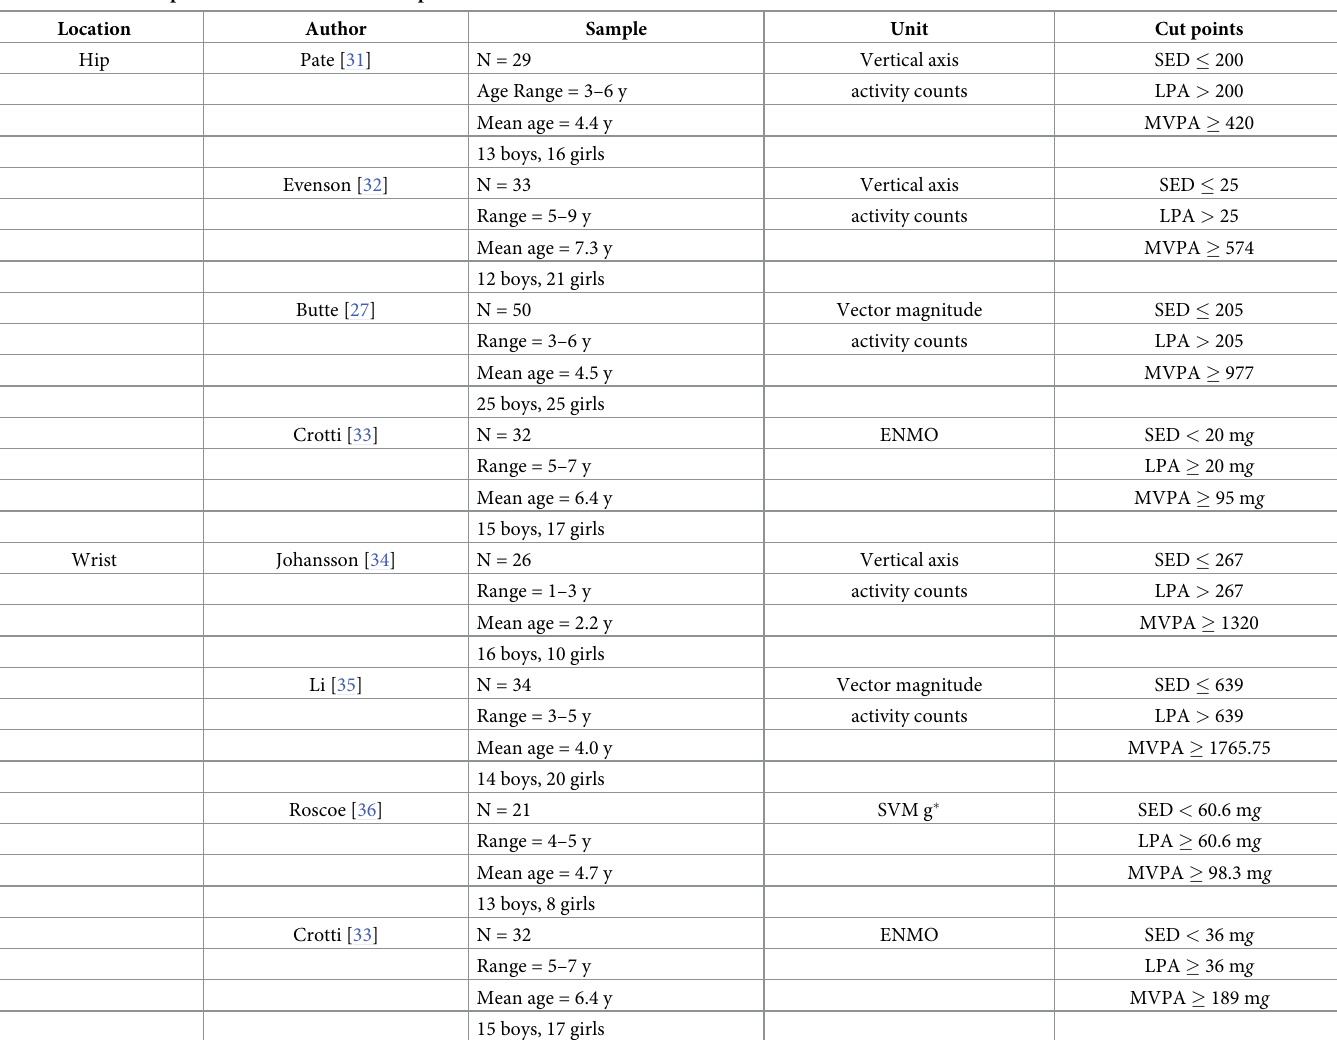
Table 1. Preschool hip and wrist accelerometer cut